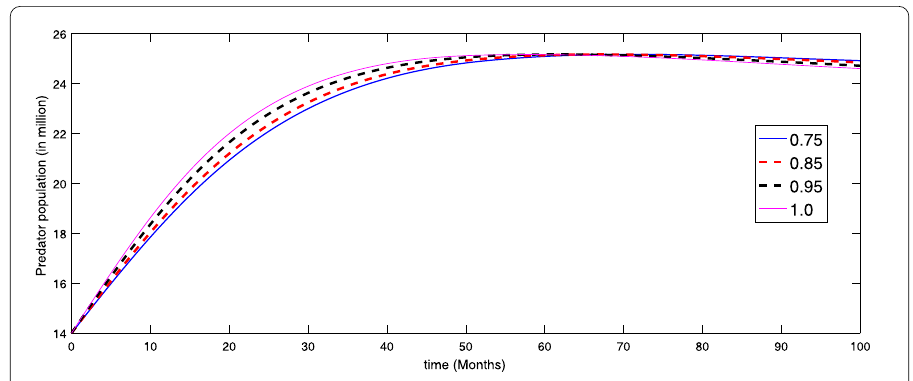
Figure 2 Graphical representation of the approximate solution v for different fractional order taking initial ten terms of the series in Case I